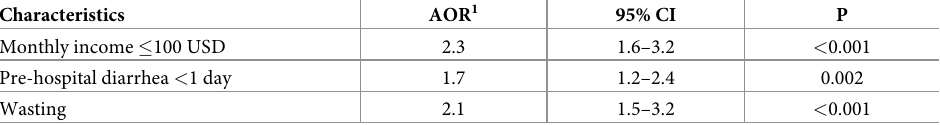
Table 4. Results of multiple logistic regression to explore the independent predictors of clinical dehydration among rotavirus-infected under-five children in Matlab.